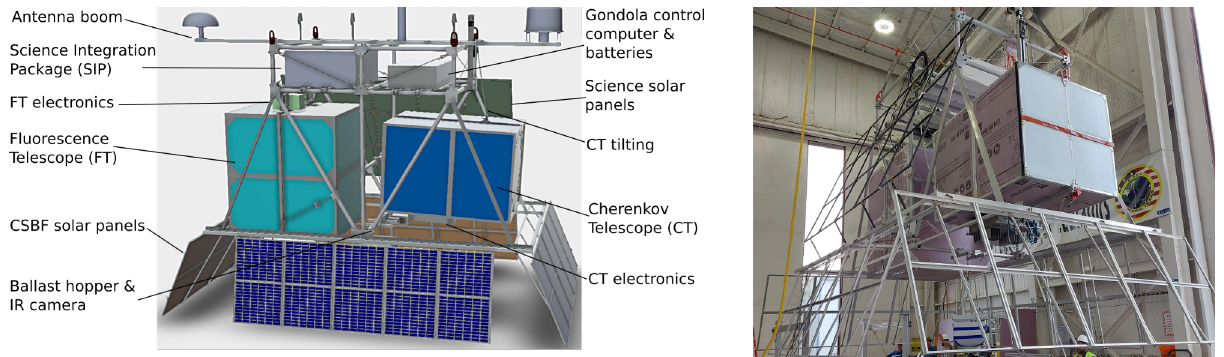
Figure 2: The EUSO-SPB2 payload. The left panel shows a labeled design drawing of EUSO-SPB2 including all the long duration balloon flight equipment such as solar panels and telecommunication antennas next to the two telescopes and the IR camera for cloud monitoring. The right panel shows the fully assembled payload during hang testing at the CSBF facility in Palestine, TX in November 2022.